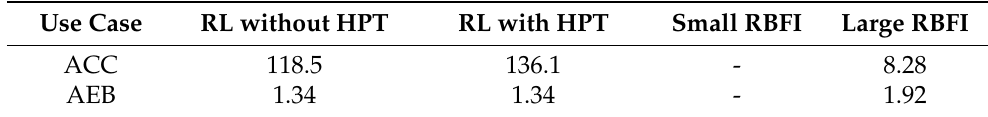
Table 7. Maximum severity of the found